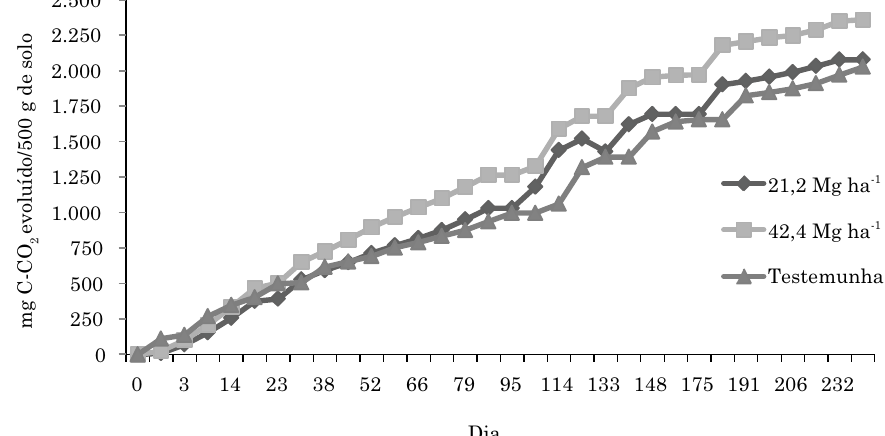
Figura 1. evolução de c-co 2 em razão das doses de lodo de esgoto aplicadas no ensaio i em Nitolosso Háplico álico textura argilosa, coletado da camada de 0,00-0,20 m, de área localizada em piracicaba,